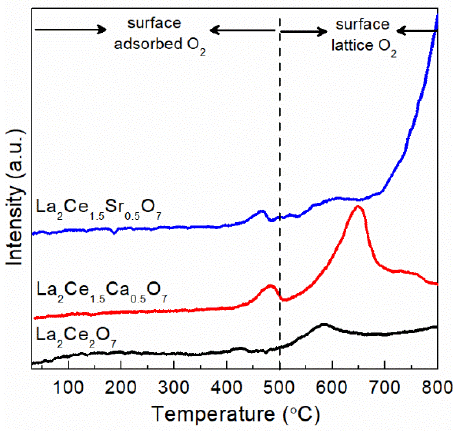
Figure 14. H 2 -TPR profile of the indicated catalysts.